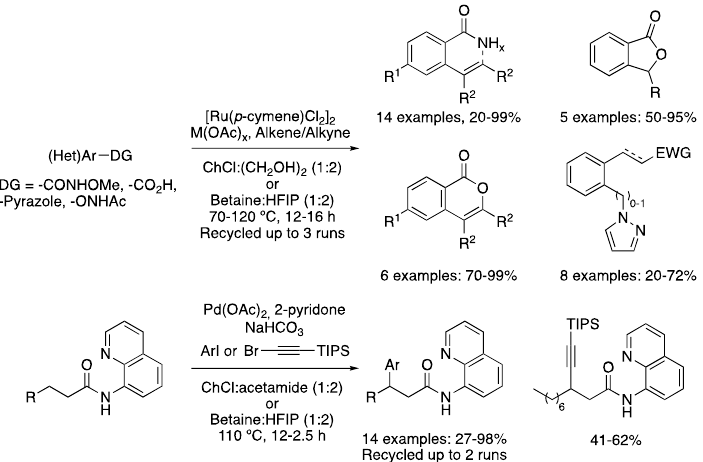
Figure 32. Ru and Pd catalyzed C-H functionalization. Table 4. Selected examples of C-H functionalizations catalyzed by transition metals in